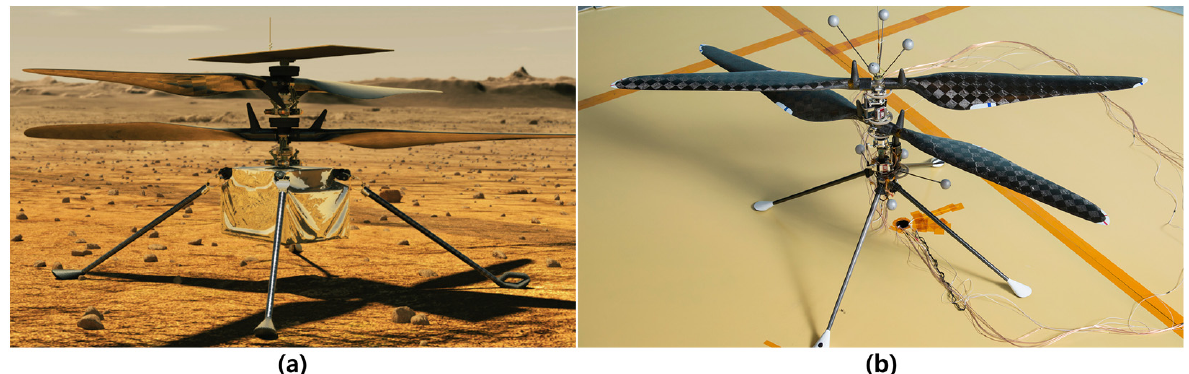
Figure 1. Example of space application of multicopter: ( a ) illustration of Mars Helicopter Ingenuity [6]; ( b ) demonstration model of Mars Helicopter powered through an electrical tether hanging below the vehicle during controlled-flight test [8].